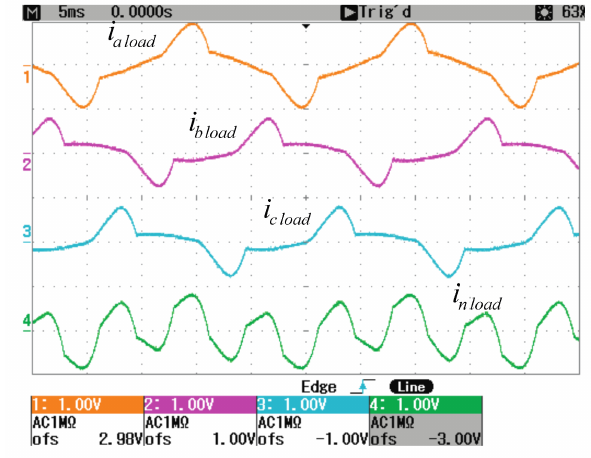
Figure 5. Experimental load currents (network currents before